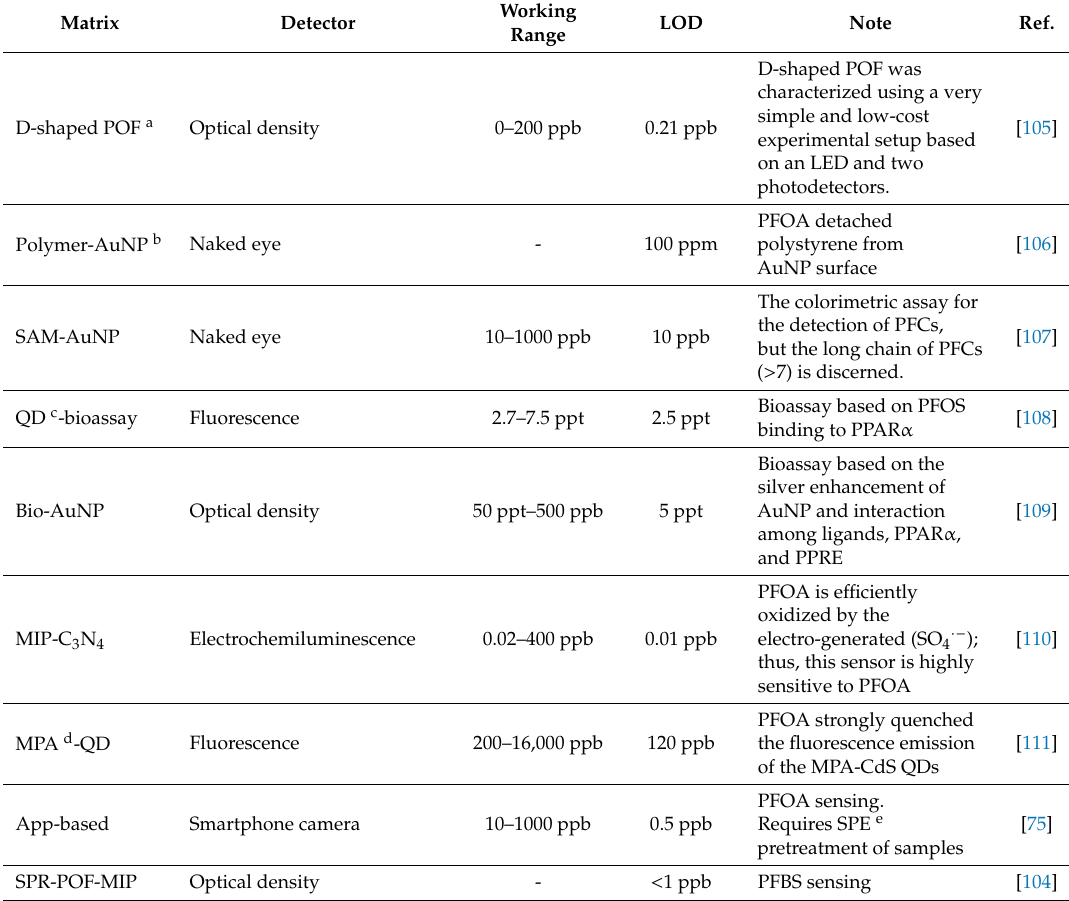
Table 3. Summary of the various optical and fluorescence sensors for PFAS